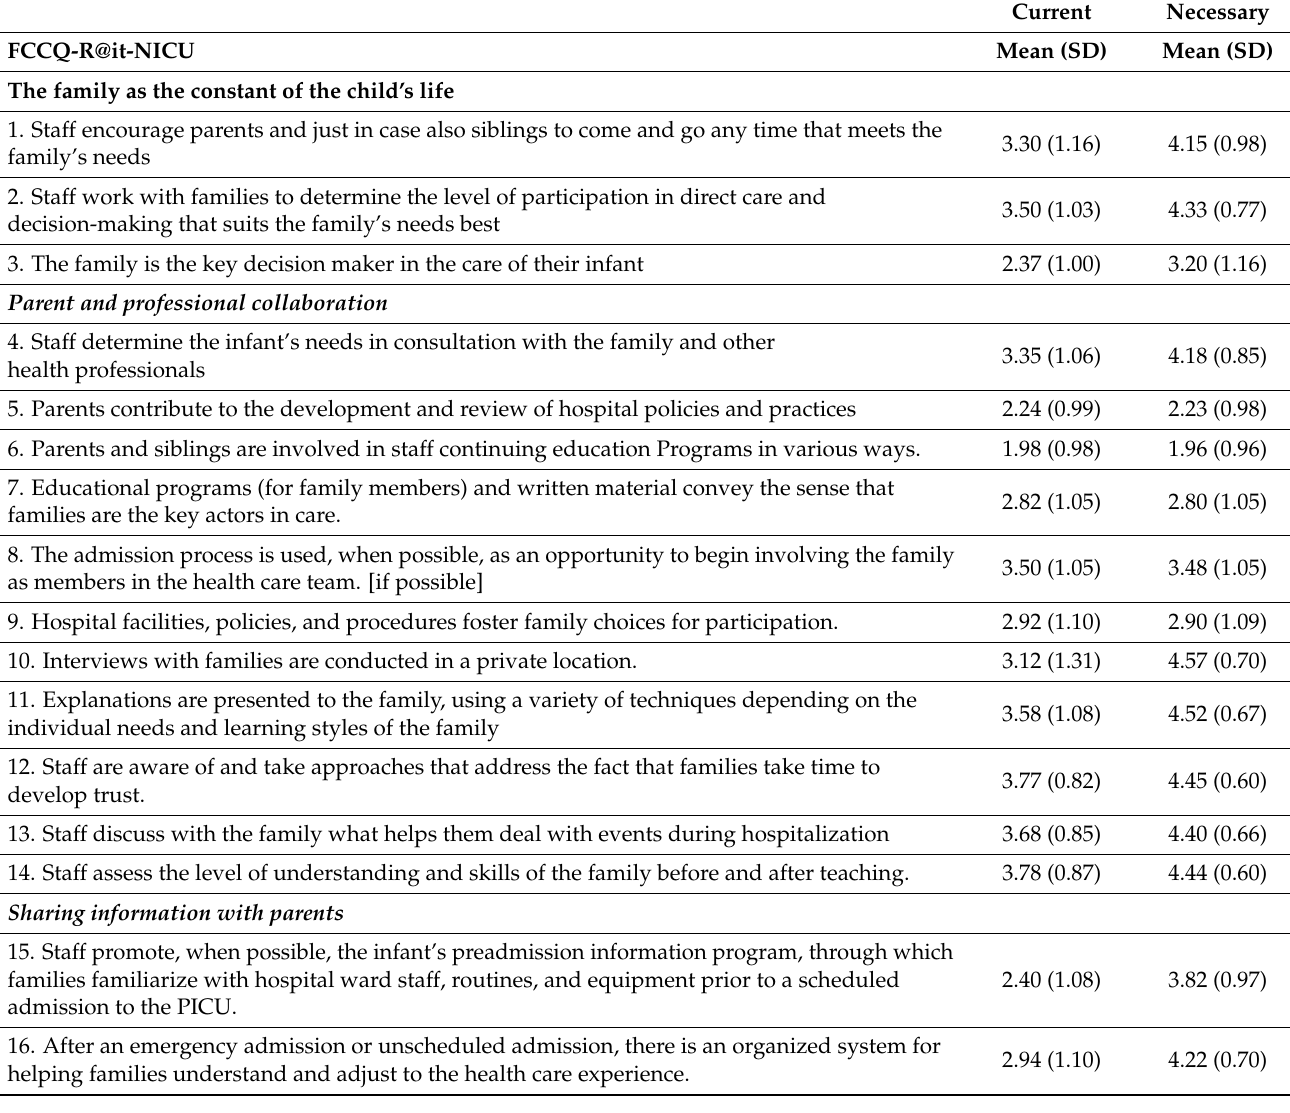
Table A1. FCCQ-R@it-NICU Comparison between Current and Necessary